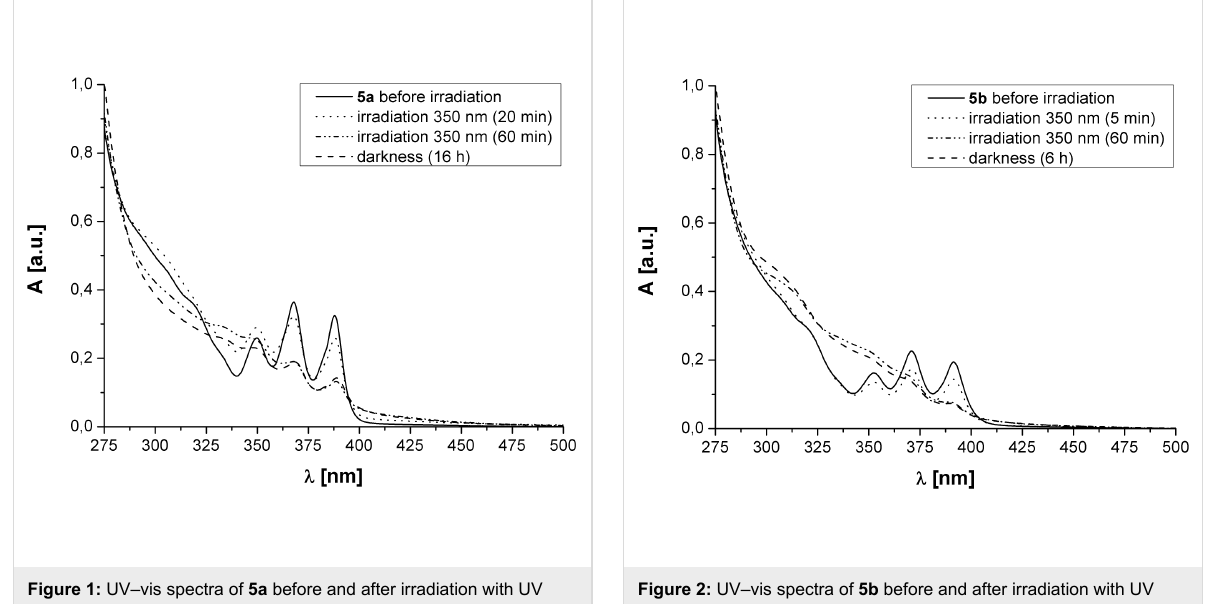
Figure 1: UV–vis spectra of 5a before and after irradiation with UV light.